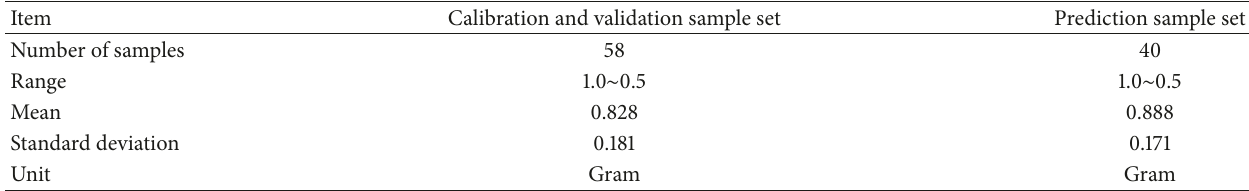
Table 1: Descriptive statistic of luwak content in coffee samples used for developing calibration and prediction in luwak-arabica coffee